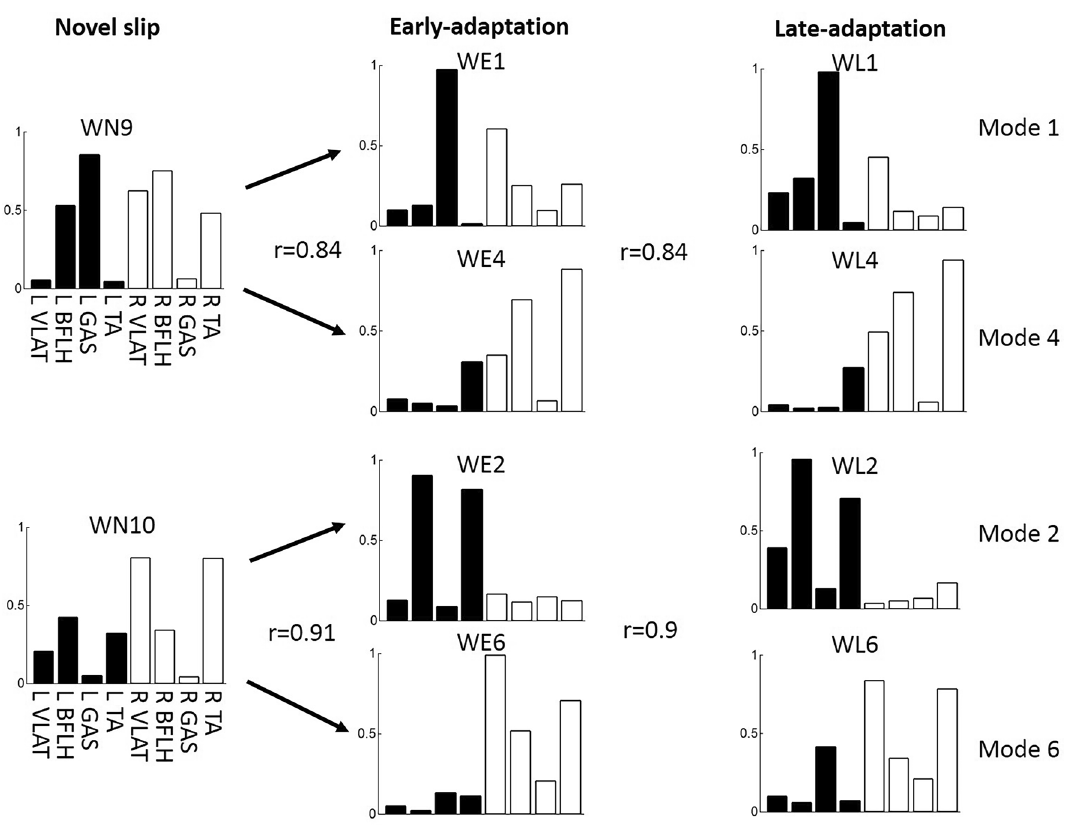
Figure 4. The fractionation (or merging) of muscle synergies. WN9 could be considered as the linear combination of WE1 and WE4 in the early-adaptation stage, or the combination of WL1 and WL4 in the late- adaptation stage. WN10 could be considered as the linear combination of WE2 and WE6 in the early-adaptation stage, or the combination of WL2 and WfL6 in the late-adaptation